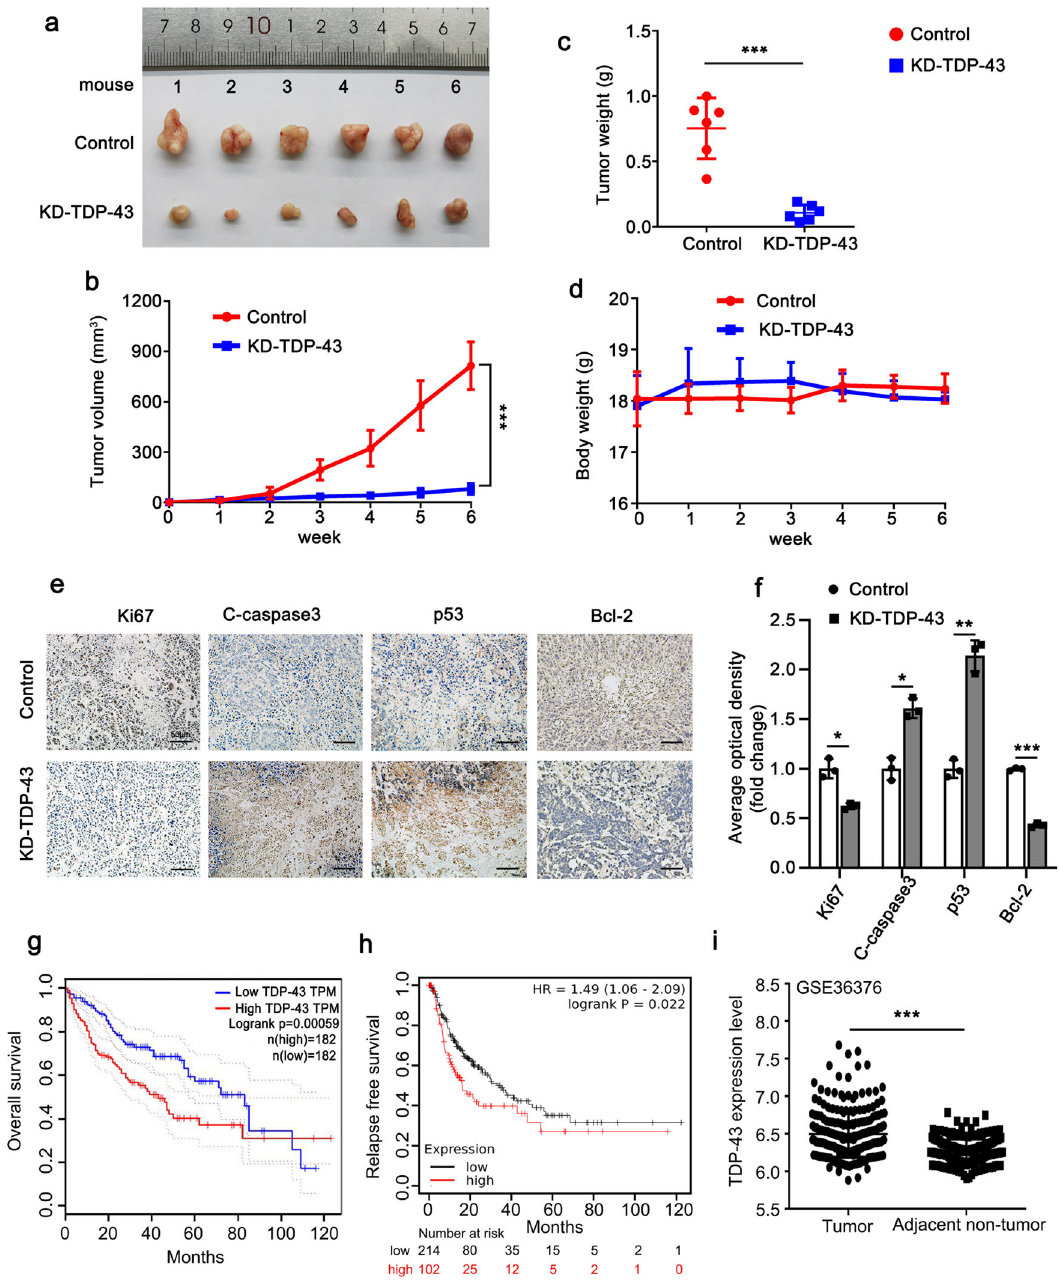
Fig. 2 TDP-43 accelerates growth and inhibits apoptosis in liver tumor. Tumor images ( a ), tumor growth curves ( b ), and tumor weights ( c ) of the xenograft tumors derived from MHCC97H-KD-TDP-43 and MHCC97H-Control cells ( n = 6). d The body weights of mice in the indicated groups. IHC staining of Ki67, C-caspase3, p53, and Bcl-2 in mice xenograft tumors ( e ) and quantitative analysis ( f ). Scale bar: 50 µ m. g , h Overall survival and relapse- free survival were analyzed in HCC cancer patients using the GEPIA (http://gepia.cancer-pku.cn/) and Kaplan – Meier plotter (http://kmplot.com/ analysis/) online databases, respectively. Plots were generated based on the expression level of TDP-43 (g plot: logrank P = 0.00059; h plot: logrank P = 0.022). i The expression levels of TDP-43 in liver tumor tissues and normal tissues adjacent to the tumor were counted from GEO database GSE36376. Error bars represent ± s. d. * P < 0.05, ** P < 0.01, *** P < 0.001 by two-tailed Student ’ s t